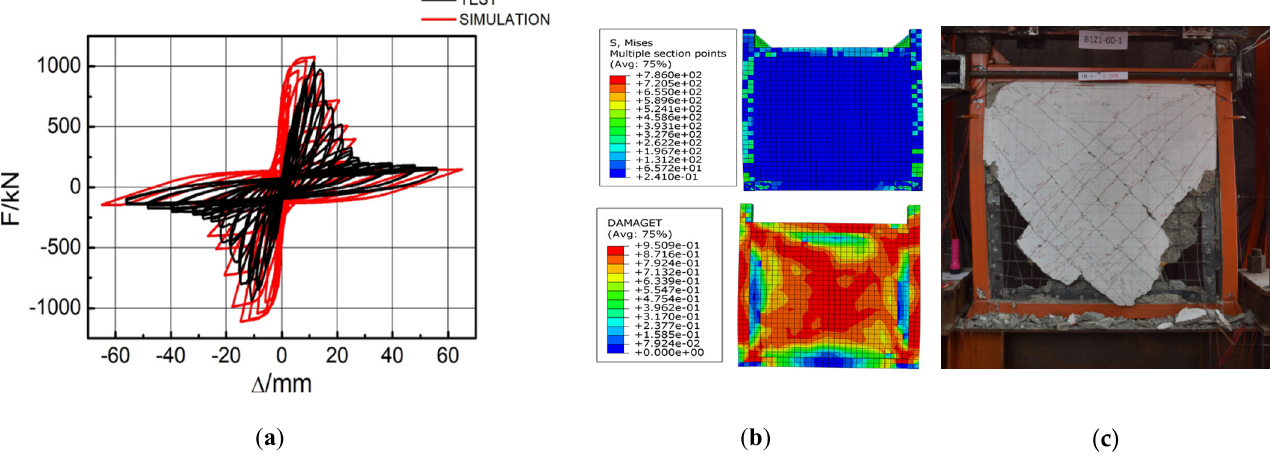
Figure 3. Comparison of simulation and literature 35. ( a ) Comparison between experimental curves and simulated curves. ( b ) Stress contour plots; ( c ) experimental damage